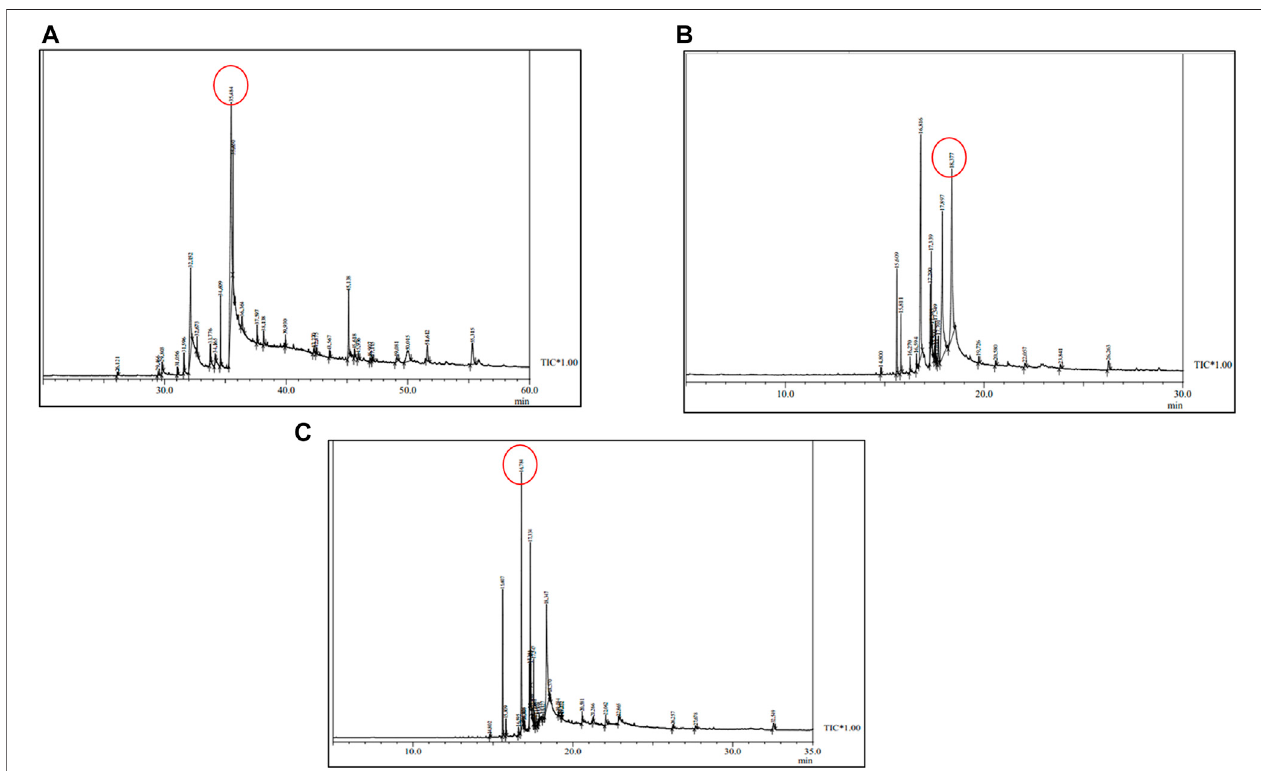
FIGURE5| Total ion chromatogramsobtained after GC-MSanalysisof Cordyceps sinensis supercriticalcarbon dioxide extracts. Basedon areapercentages, the most abundant volatile organic compounds in CSF1, CSF2 and CSF3 were revealed to be 9,12-octadecadienoic acid (Z,Z)- (A) ; 9,12-octadecadienoic acid (Z,Z)-, trimethylsilyl ester (B) and hexadecanoic acid, trimethylsilyl ester (C) , respectively.